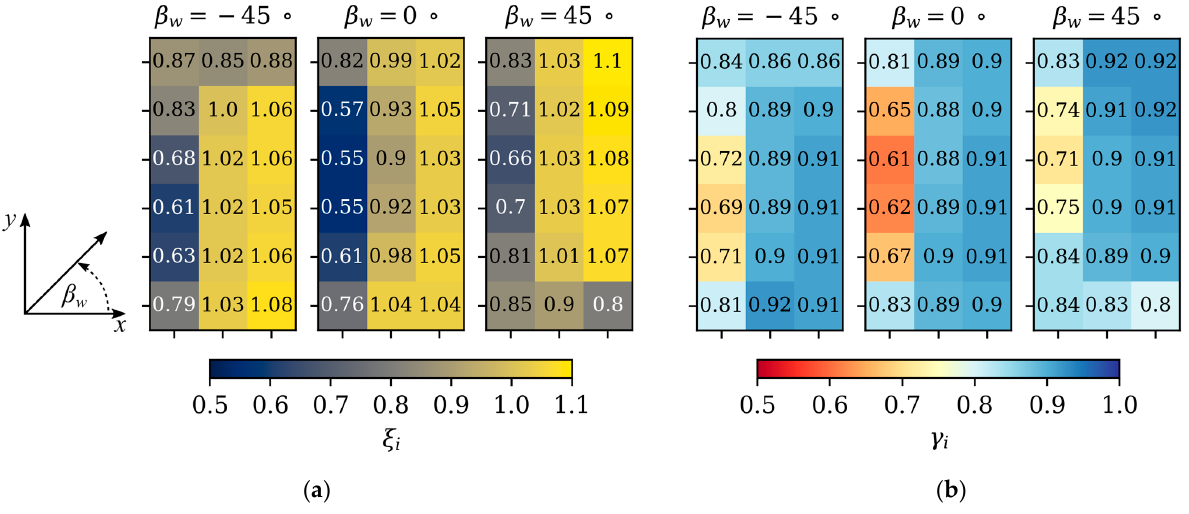
Figure 6. Numerically predicted individual fan cell: ( a ) volumetric effectiveness; ( b ) uniformity index, with changing wind direction ( v w = 7 m/s).